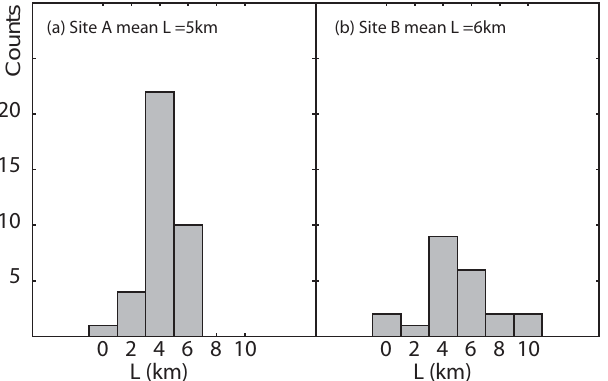
Figure 6. Soliton width ( L ) distribution for the leading ISWs in each packet.